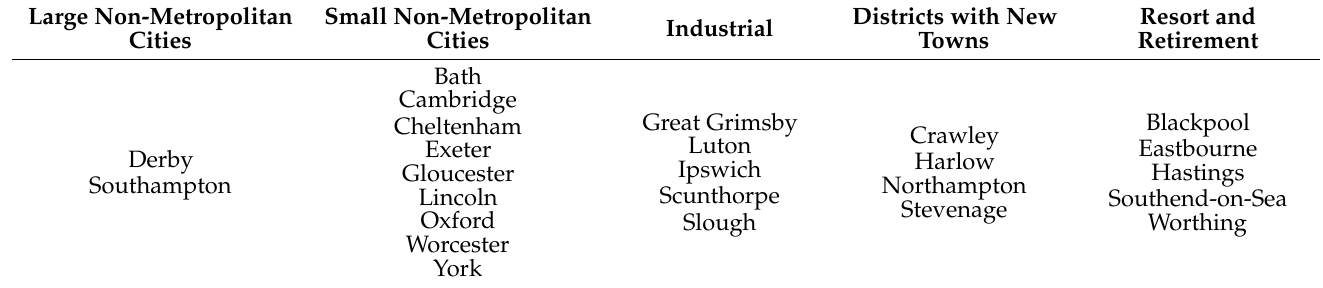
Table 1. The sample of 25 English cities used in Burton’s studies, divided based on the local author- ity